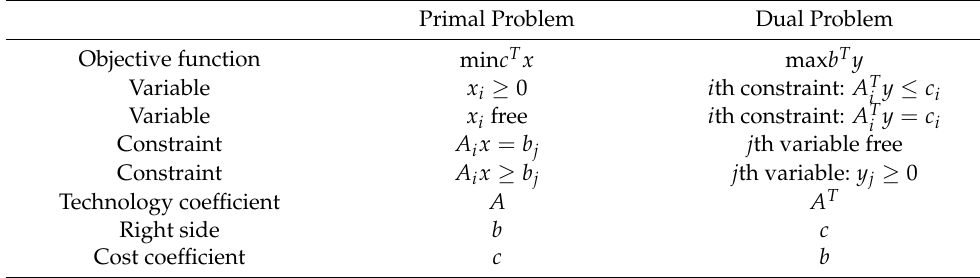
Table 2. Rules for constructing dual